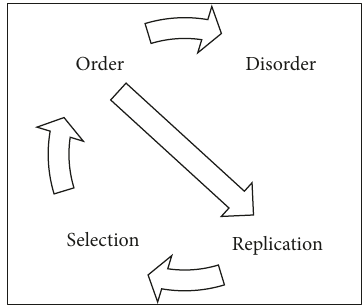
Figure 1: The selective and entropic processes as the primary causes of order and disorder. The linked concepts in the figure’s upper half (order and disorder) represent the entropic process of ever-increasing disorder. The linked concepts in the lower half (replication and selection) represent processes of biological or cosmological natural selection: genetic or universe designs which outreplicate others achieve, via selection, greater representation in a population or multiverse. Selection leads to order because it produces the most orderly (and thus least entropic) known objects in the universe—adaptations—the function of which is to enable replication against the tide of the entropic process. Because adaptations must realize the complex goal of replication, they are characterized by improbable complex order, and such order is the hallmark of selection. The more improbably and complexly ordered something is (i.e., the lower its entropy), the more likely it is to be a biological or cosmological adaptation; intelligent life would thus be more likely than black holes (or anything else) to be a cosmologicaladaptation. Selectionmaybethemainoronlyultimate antientropic process in the universe/multiverse; that is, much or all order we observe may be the product or by-product of selection for replication at the biological and cosmological